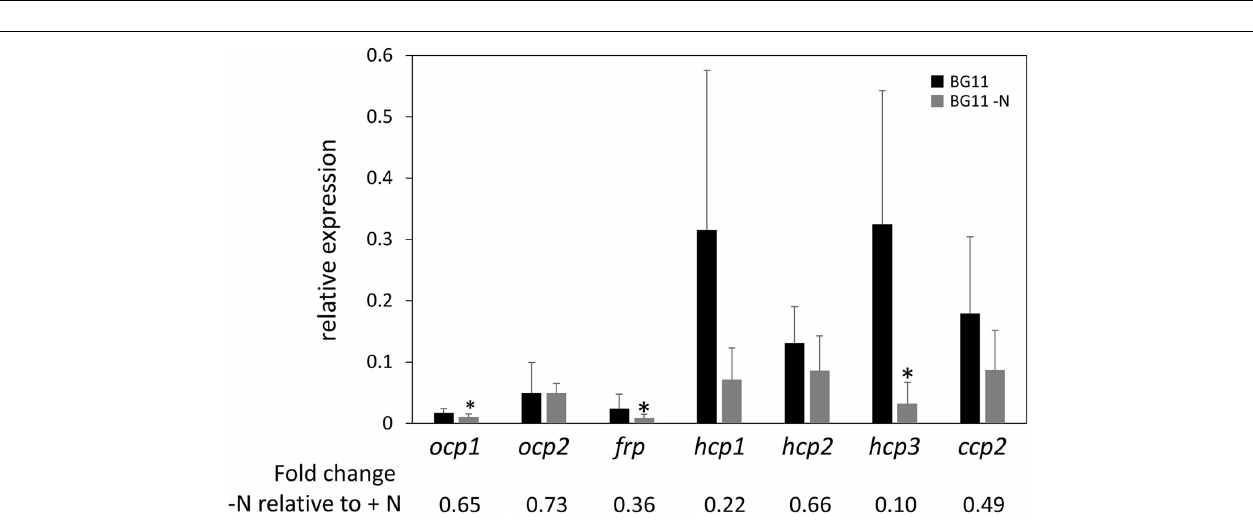
FIGURE 4 | Expression of ocp homologs in response to salt stress. The expression levels of ocp1 , ocp2 , frp , hcp1 , hcp2 , hcp3 , and ccp2 were measured using qPCR, comparing samples incubated for 24 h in BG-11/HEPES + 0.2 M NaCl to control samples grown in BG-11/HEPES ( ± SD, n = 6). ∗ p < 0.05 as determined by a two tailed Student’s t -test for the comparison of the treated and untreated samples.